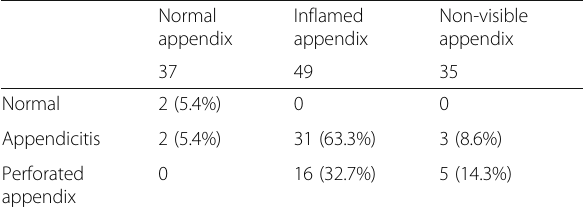
Table 5 Surgical findings in regard to ultrasonographic